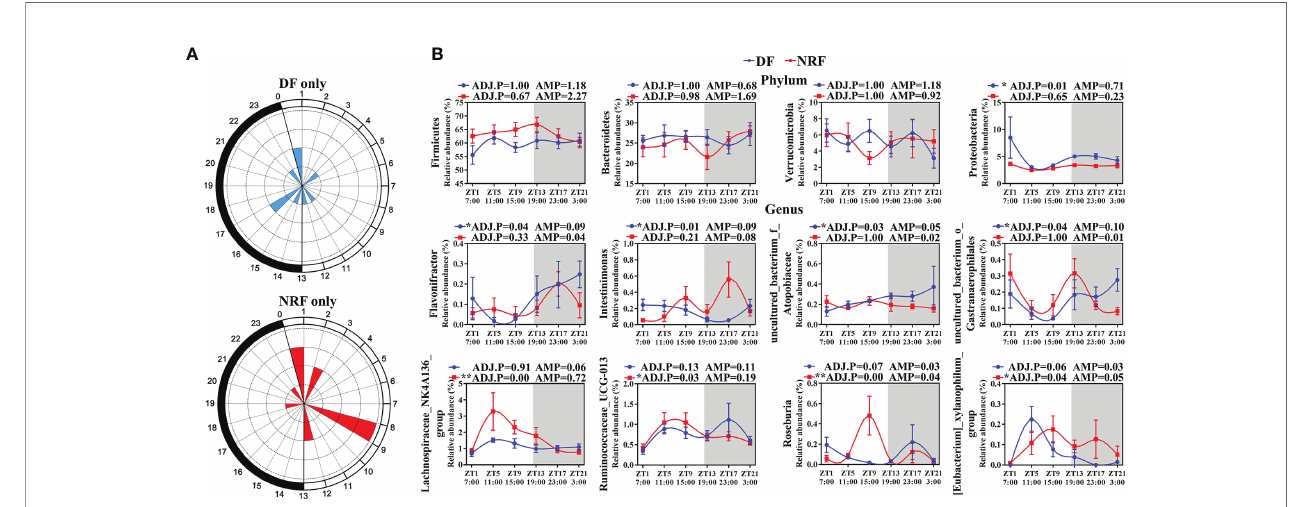
FIGURE 3 | The diurnal rhythm of gut microbiome phyla and genus under different feeding time regimens. (A) Polar plot represents the number of rhythmic ASVs with an estimated peak value for each time as determined by JTK analysis. The radius of black concentric circles indicates the number of rhythmic ASVs, and the minimum radius of the black concentric circle represents one ASV. The black arc on the left side of the polar plot indicates the day/night cycle. (B) The diurnal rhythm of gut microbiome at phylum and genus level (n = 6 per time point), data are shown as the mean ± SEM. White boxes indicate daytime and gray boxes indicate nighttime. ADJ.P for adjusted minimal p -values, ADJ.P < 0.05 indicates signi fi cant diurnal rhythm, AMP represents amplitude. DF, daytime feeding; NRF, night-restricted feeding. *ADJ.P < 0.05; **ADJ.P <